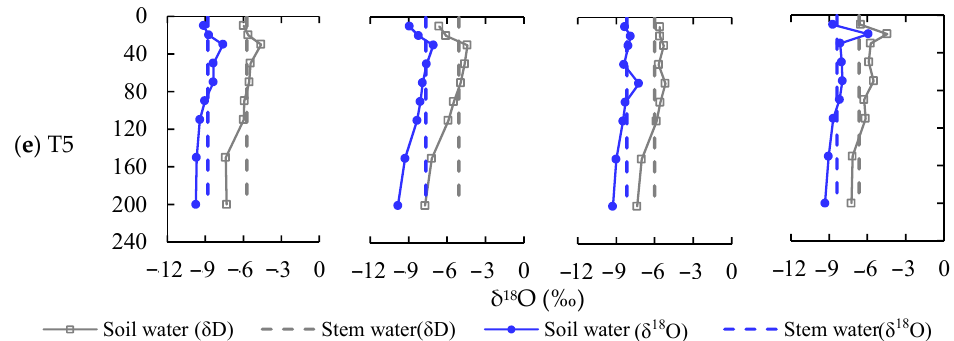
Figure 5. δ D and δ 18 O in soil water and stem water at each growth stage of winter wheat in the 2014 season for treatment: ( a ) T1, ( b ) T2, ( c ) T3, ( d ) T4, and ( e ) T5.